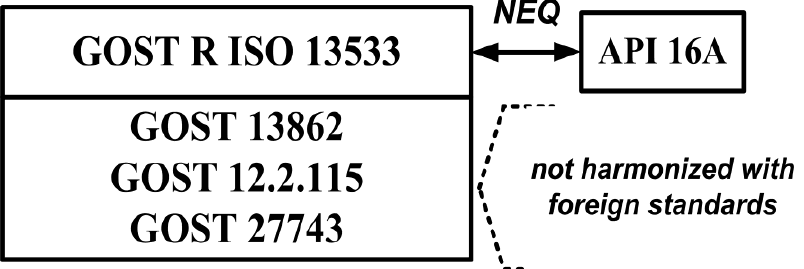
Figure 4. Harmonization degree between Russian and foreign